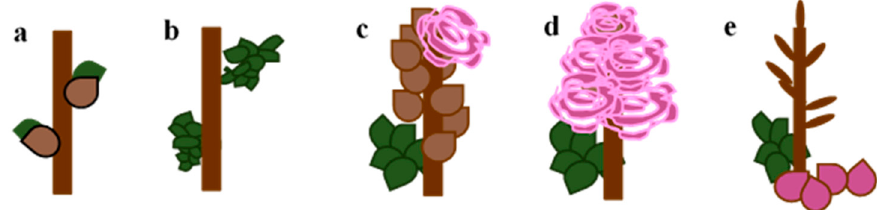
Figure 3. The chosen phenology stages of observation of shrubs: ( a ) BCH 07—beginning of bud breaking, first green leaf tips visible; ( b ) BBCH 11—first leaf pair unfolded, not yet at full size, leaves are light green and/or bronze; ( c ) BBCH 60 601—beginning of flowering: about 10% of flowers open; ( d ) BBCH 63 605—full flowering: at least 50% of flowers open; and ( e ) BBCH 69 609—end of flowering: all petals have fallen.